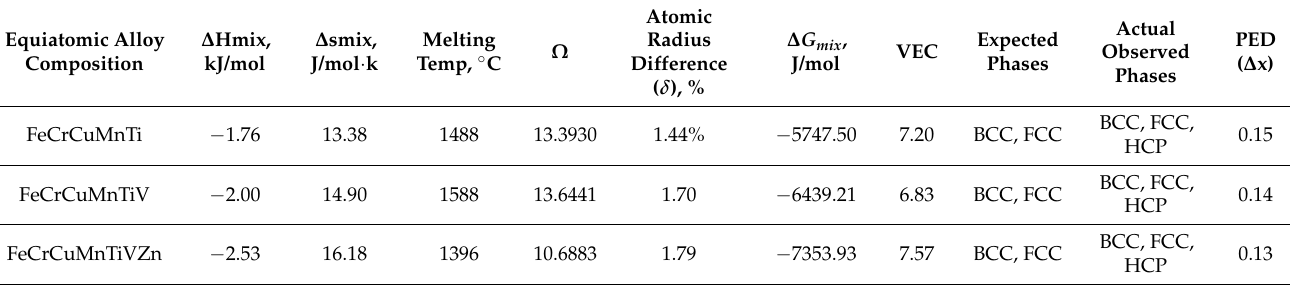
Actual Expected Observed Phases Phases